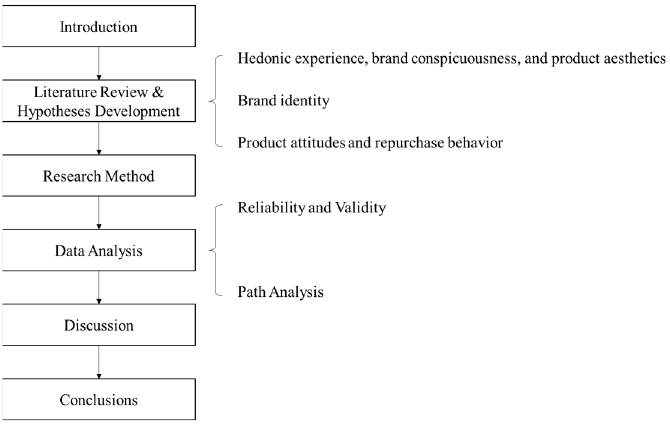
Figure 1. Diagram of the research.